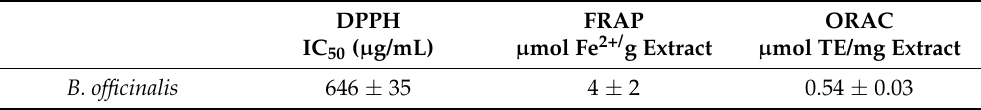
Table 2. Antioxidant activity of B. officinalis flower extract. The results are presented as mean ±